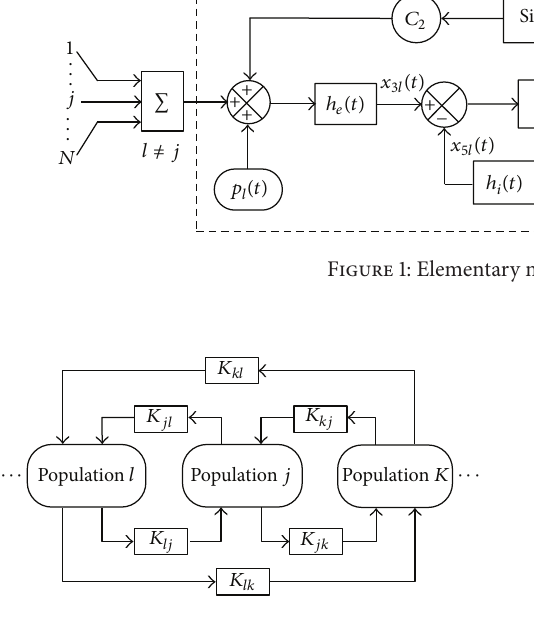
Figure 2: Model of multiple coupled neural